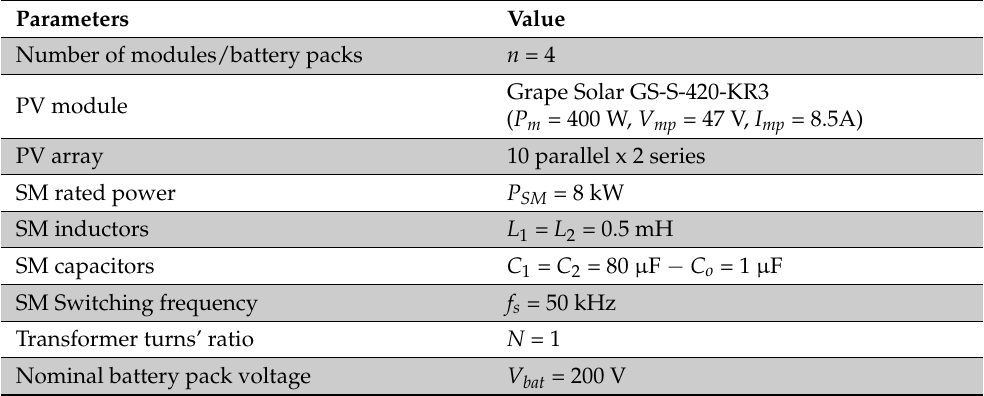
Table 3. Parameters of the SIMULINK/MATLAB case study for Mode 2.